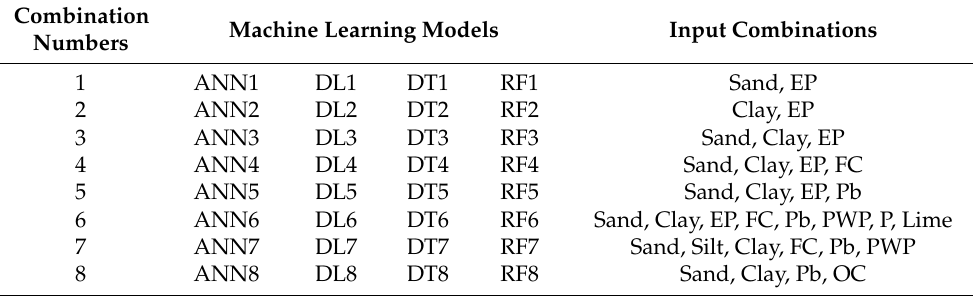
Table 3. Input combinations of each machine learning